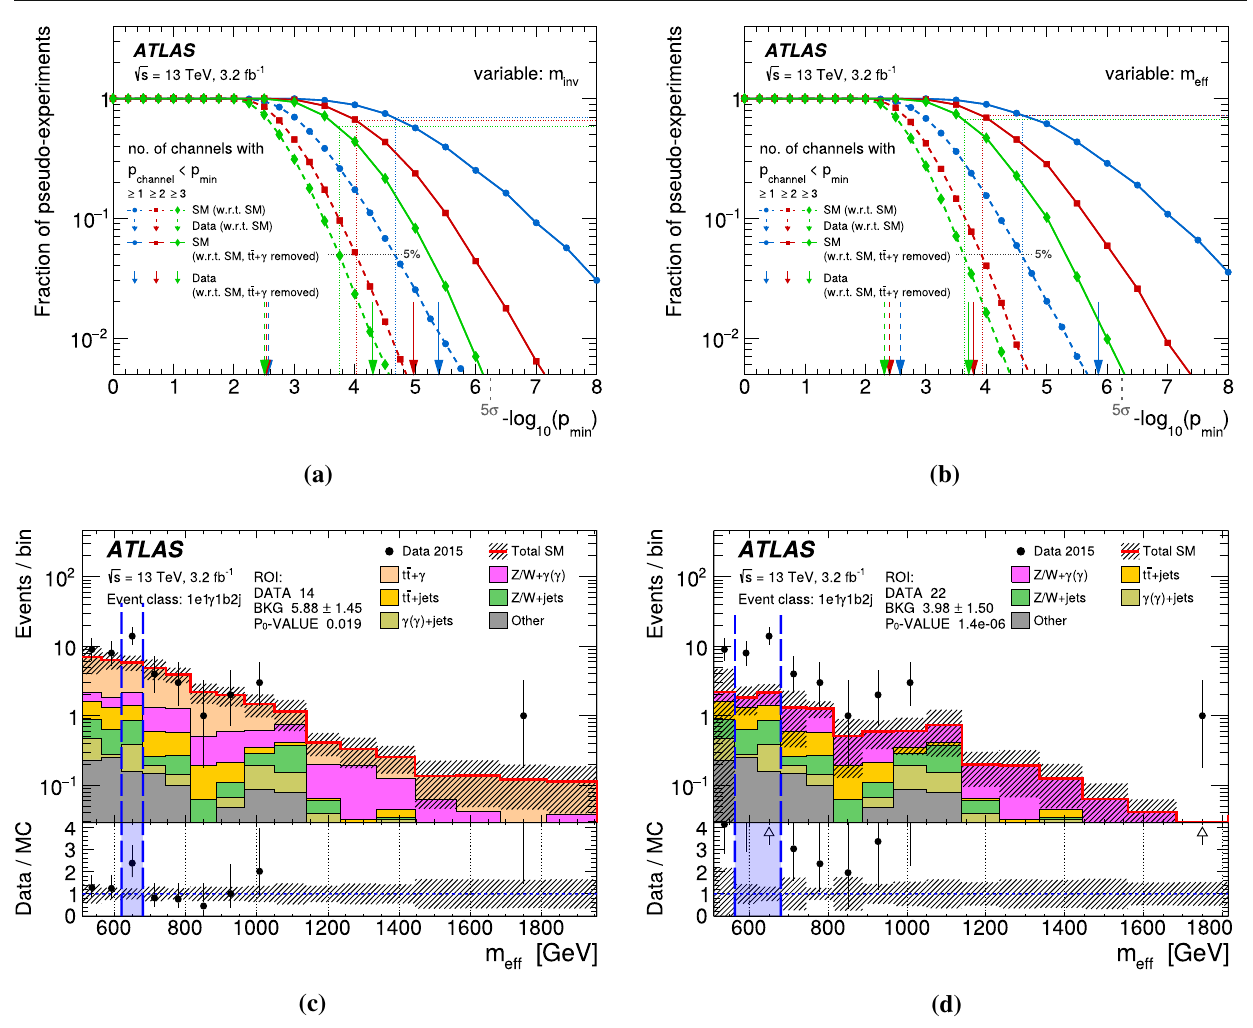
Fig. 7 Thefractionofpseudo-experimentswhichhaveatleastone,two and three p channel -values below a given p min , given for both the pseudo- experiments generated from the nominal SM expectation and tested against the nominal expectation (dashed) and for those tested against the modified expectation (‘SM, t ¯ t γ removed’) in which the t ¯ t γ process is removed (solid). The m inv scan is shown in a and the m eff scan in b . The horizontal dotted lines show the fractions of pseudo-experiments yielding P exp , i < 5% when testedagainst the modified background pre-